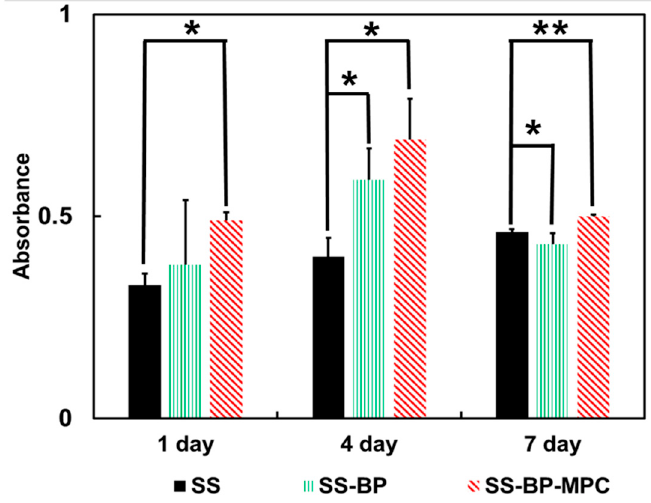
Figure 9. MC3T3-E1 cell growth on the surface of pristine SS, SS-BP, and SS-BP-MPC composites with various time intervals using the MTT assay (n = 3). Data with asterisks mean they are di ff erent from the SS sample at α = 0.05 within the same day group.